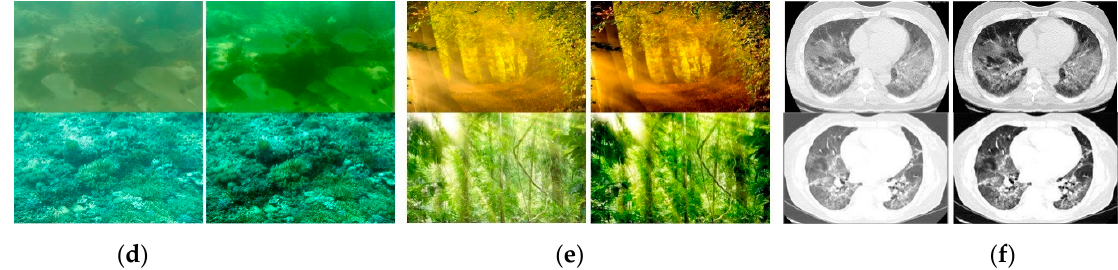
Figure 13. Extension to other potential applications. For each image pair, the left image is the input image and the right image is the enhanced image using the method described in this paper. ( a ) Night-time image; ( b ) remote sensing image; ( c ) low-contrast image; ( d ) underwater images; ( e ) images with halation; ( f ) CT scan images.